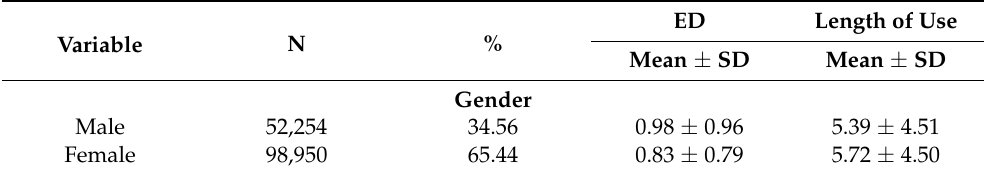
Table 2. Average dose and length of use of benzodiazepines related to socio-demographic character- istics of